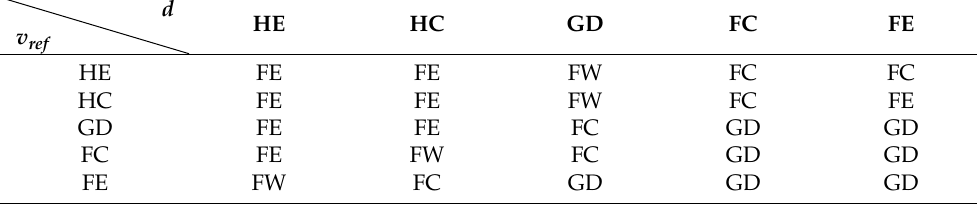
Table 1. Fuzzy control rules.